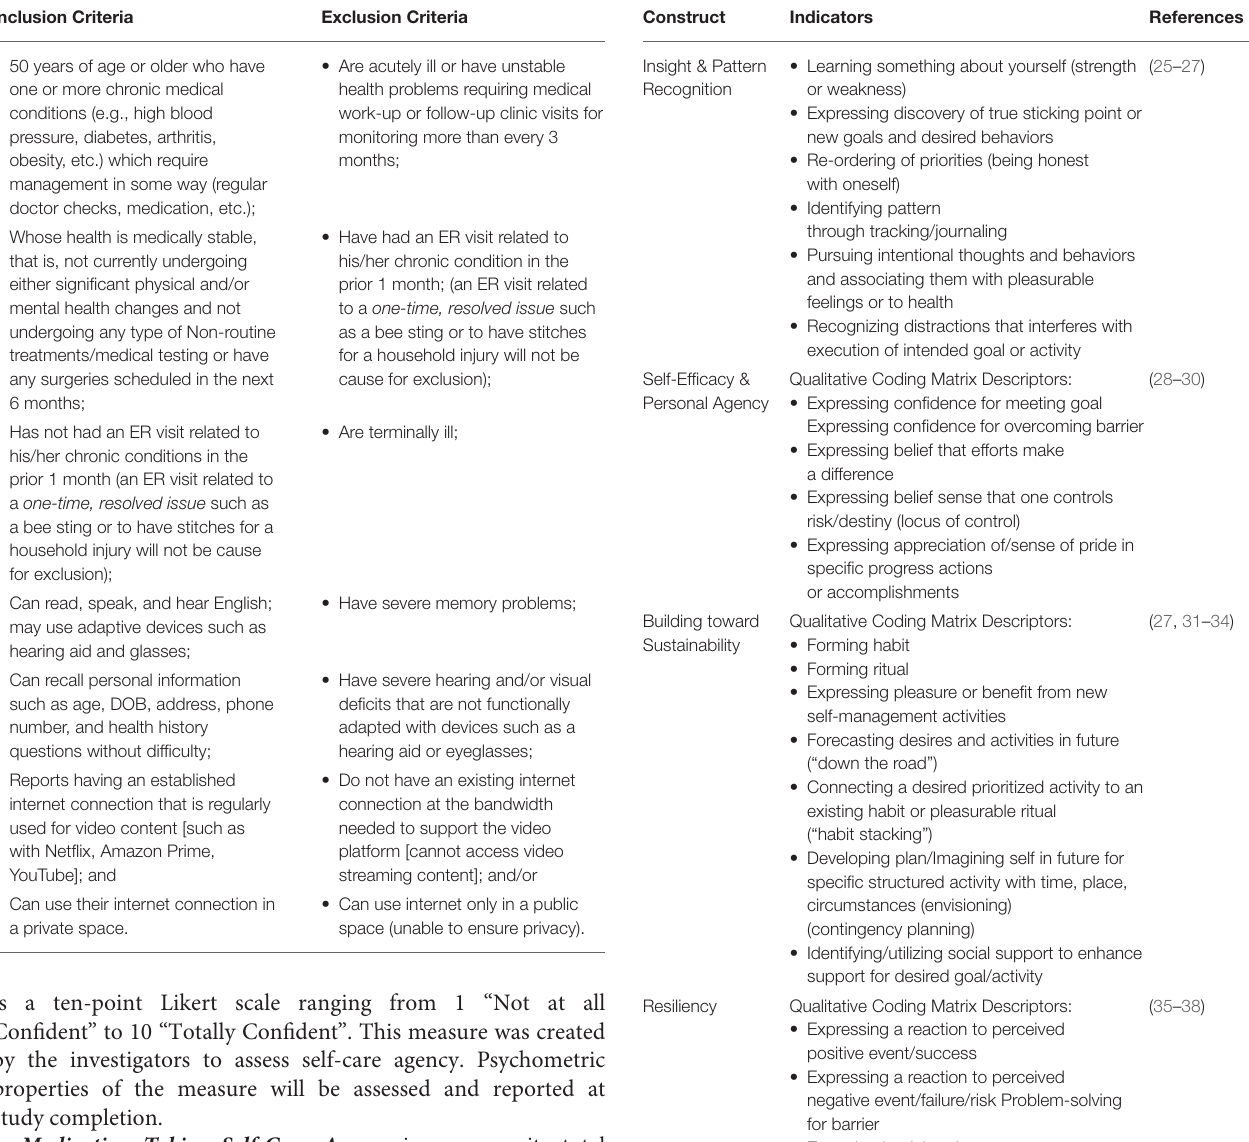
TABLE 4 | Inclusion and exclusion recruitment criteria. TABLE 5 | Qualitative outcome